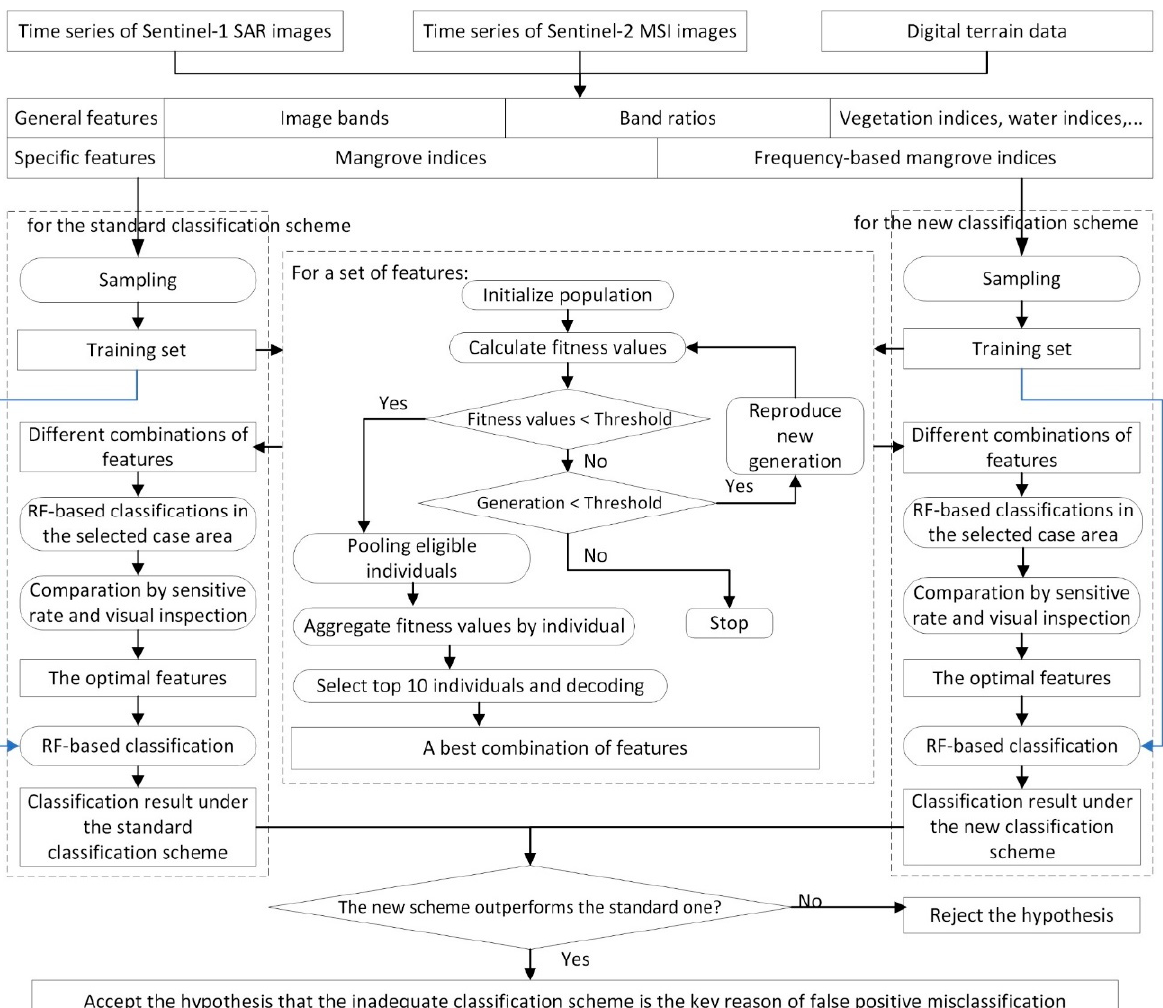
Figure 3. Workflow for validating the hypothesis. The difference is the first experiment skipped the feature selection procedure using blue arrows, thus validating the hypothesis using the same total features rather than using the optimal features that approximate the optimal feature space.